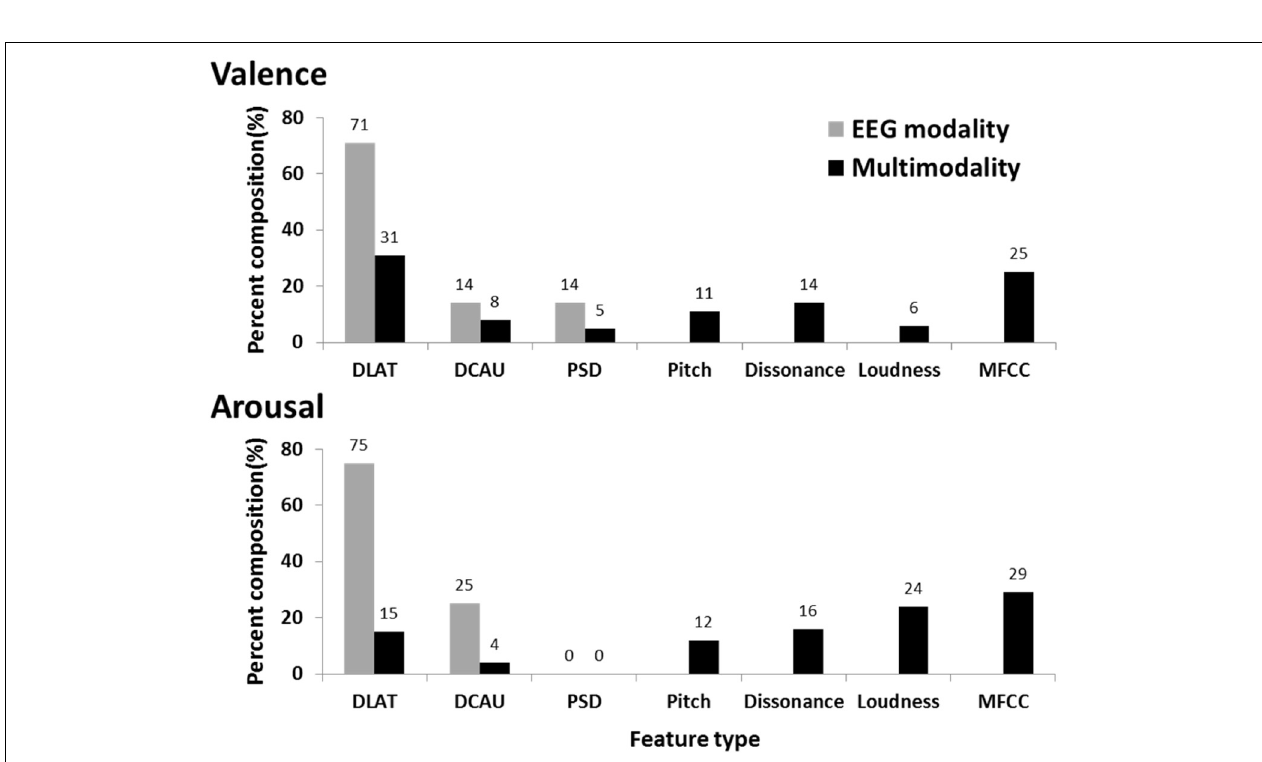
mean values of the results, whereas the numbers in bold indicate the accuracies significantly better ( p < 0 . 02) than the majority voting accuracy (valence: ∼ 63%, arousal: ∼ 61%). † indicates that the accuracy with feature selection significantly outperformed that without feature selection ( p < 0 . 01).